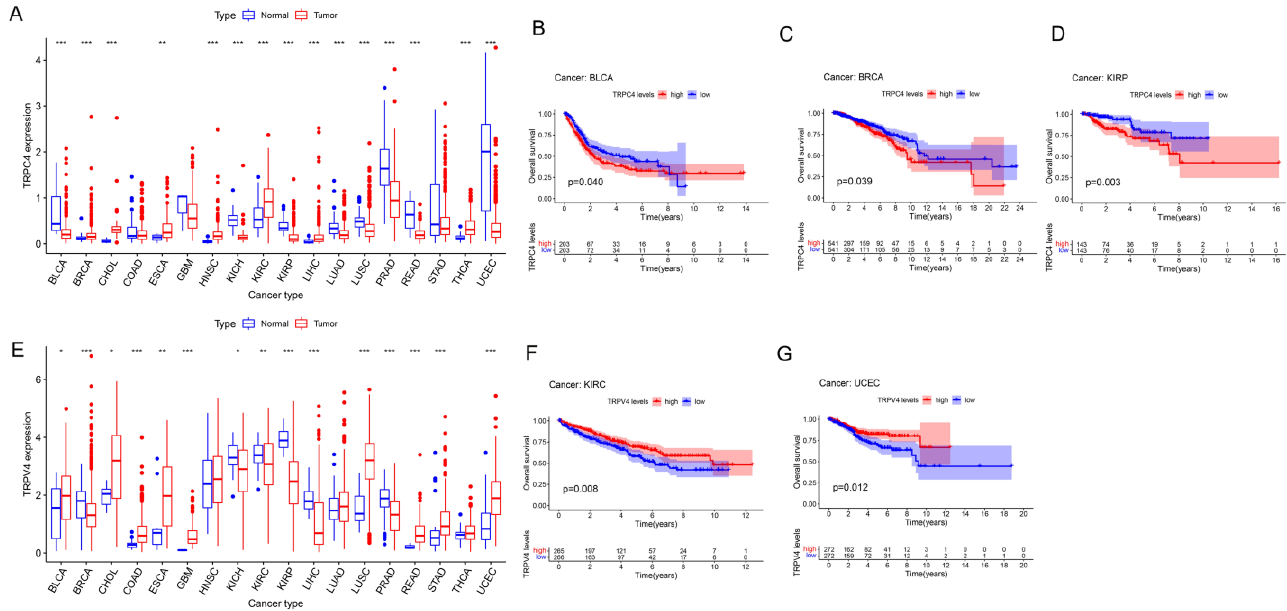
Figure 2. Different expression and Kaplan – Meier survival curves of TRPC4 and TRPV4 in pan-cancer ( A ). Differential expression of TRPC4, Kaplan – Meier survival curves of TRPC4 in ( B ) BLCA, ( C ) BRCA, and ( D ) KIRP. ( E ) Differential expression of TRPV4, Kaplan – Meier survival curves of TRPV4 in ( F ) KIRC and ( G ) UCEC. The red and blue rectangular boxes represent gene expression levels in tumor and normal tissues, respectively. * p < 0.05, ** p < 0.01, and *** p < 0.001. Red- and blue-colored names indicate high and low expressions of the corresponding TRP family genes, respectively.